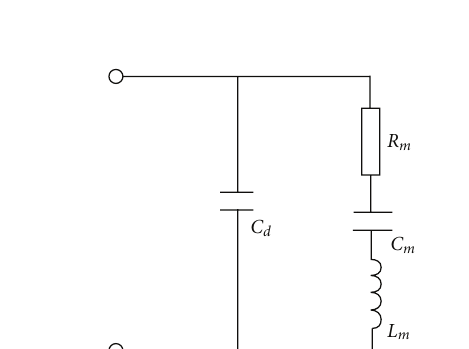
Figure 2: Structure of the driving and control circuit.